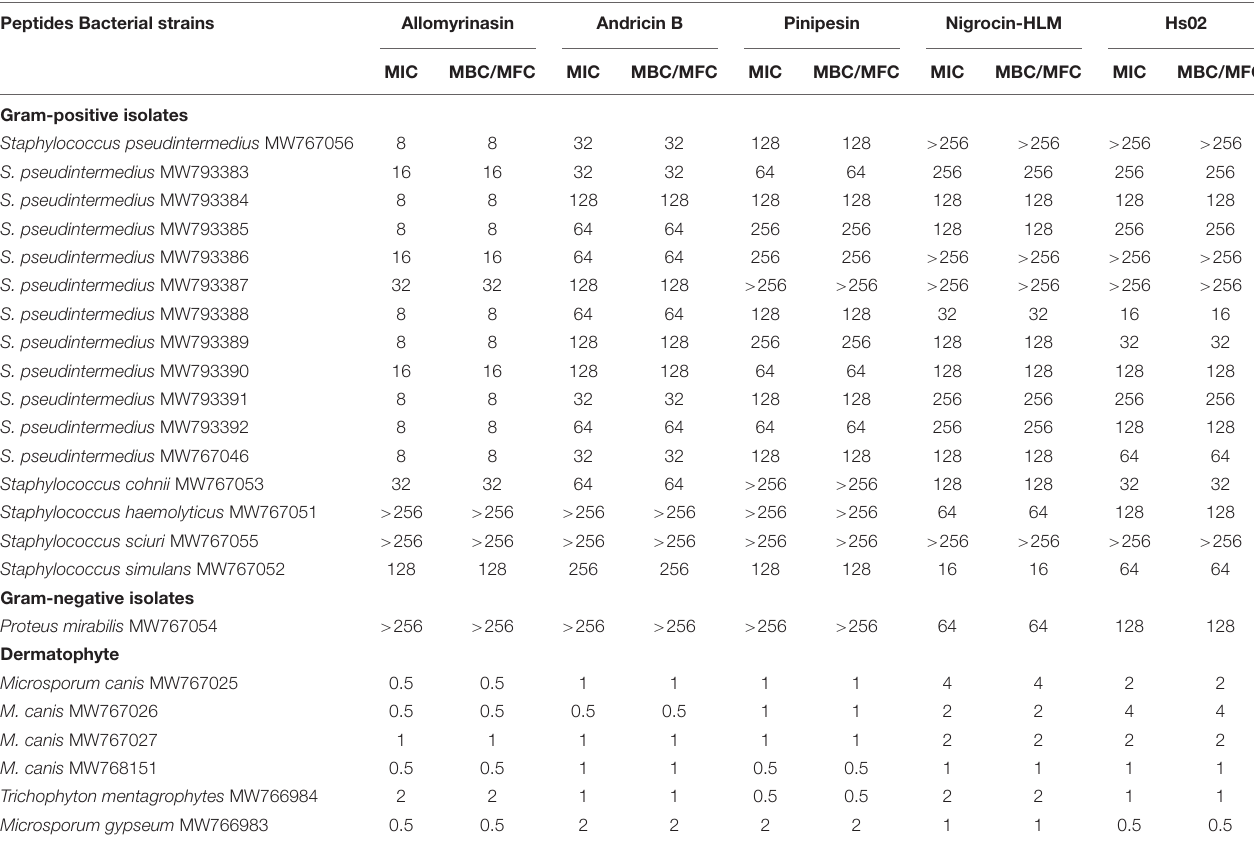
TABLE 1 | Minimum inhibitory concentrations and minimum bactericidal/fungicidal concentrations (MICs and MBCs/MFCs, µ g/ml) of selected peptides against clinical isolates of planktonic bacteria and dermatophytes. Peptides Bacterial strains Allomyrinasin Andricin